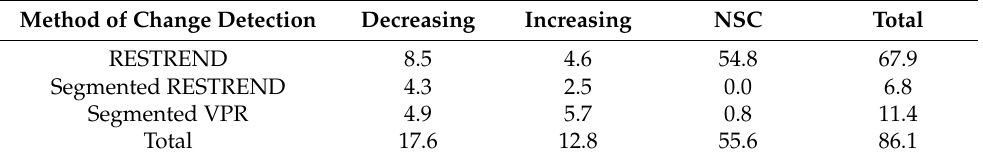
Table 3. A summary of the pixels (in % relative to 4454 pixels) and methods used to identify the direction of change in productivity in New Mexico during the 1982–2015